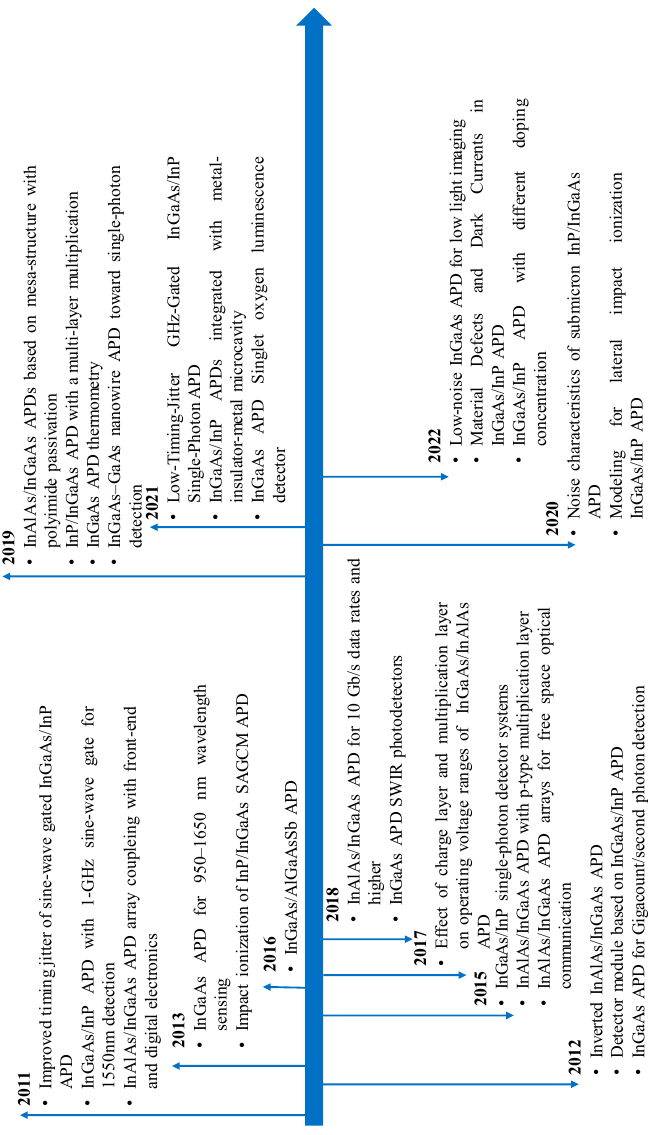
Figure 29. Research development of InGaAs APDs.